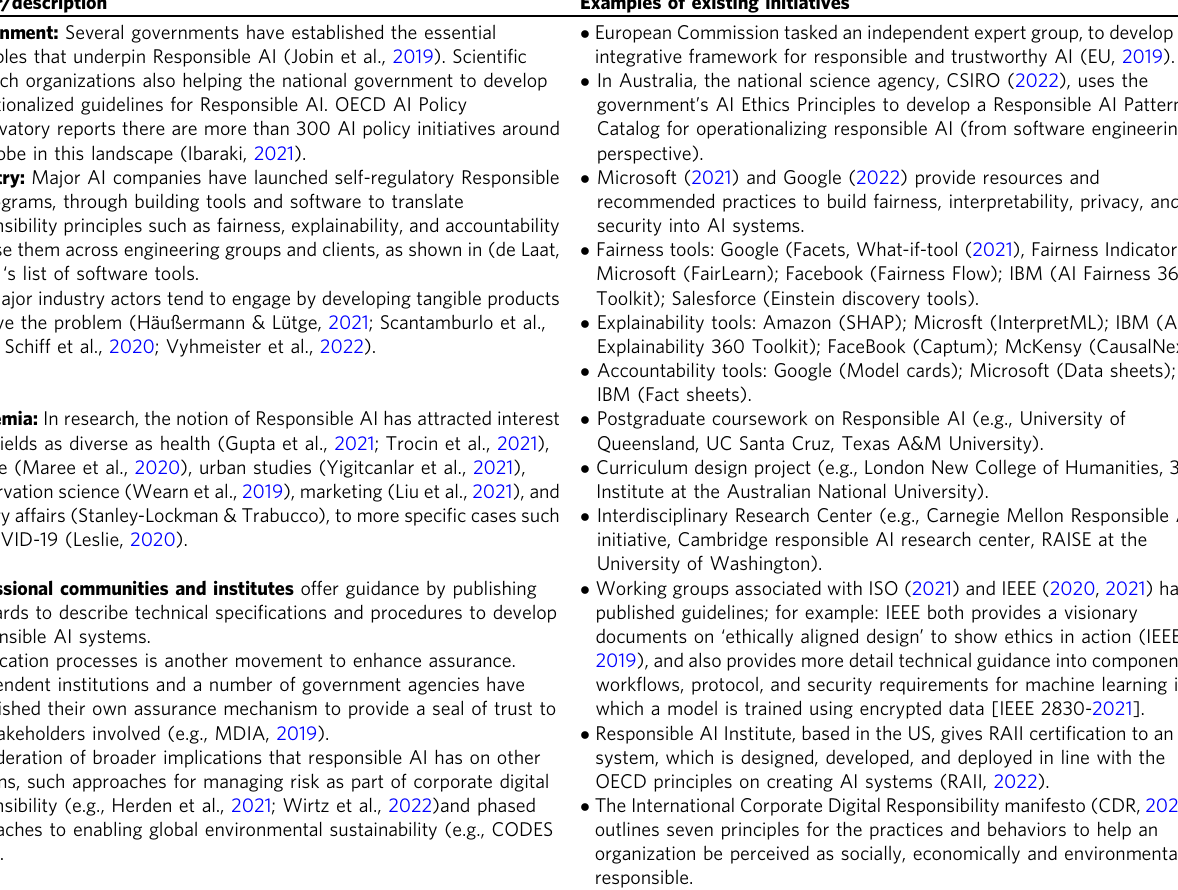
Table 1 Measures and initiatives developed by different actor/sectors to create positive change in AI management, achieving more responsible